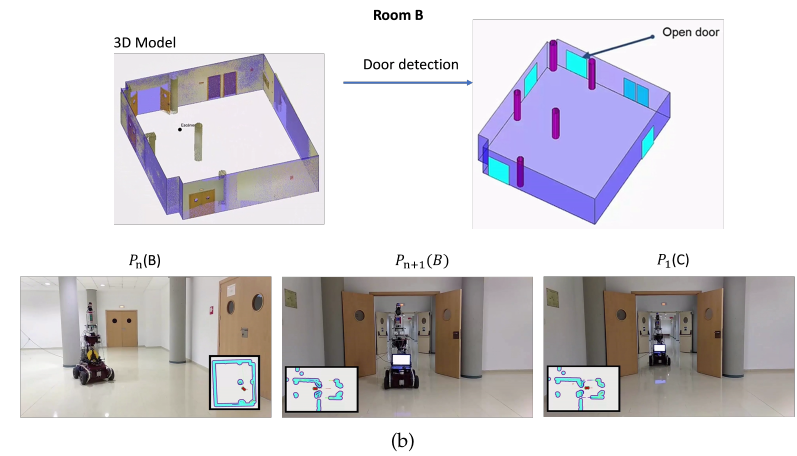
Figure 17. Open door traversal experimentation with MoPAD. ( a ) Open door traversal in room A. (Top) 3D model obtained by MoPAD after finishing the scanning process and detection of an open door. (Bottom) Pictures of MoPAD before and after going through the door. ( b ) Open door traversal in room